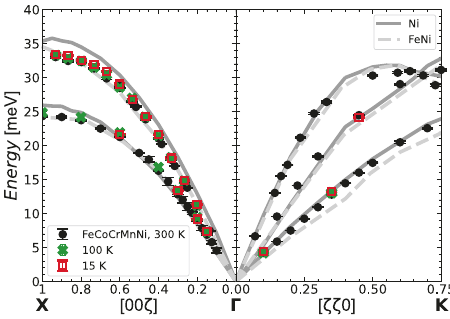
Fig. 5 | Longitudinal and transverse phonon dispersions. The energies of the longitudinalandtransverseacousticphononsofFeCoCrMnNimeasuredinthehigh symmetry directions [00 ζ ] and [ ζζ 0] seen in Fig. 3 have been fi t (details in Sup- plementary Note 2) and plotted at three temperatures against those of the single elementNi 52 andequimolarNiFe 53 measuredat300K.Errorbarscorrespondtothe standard deviation of the fi tted